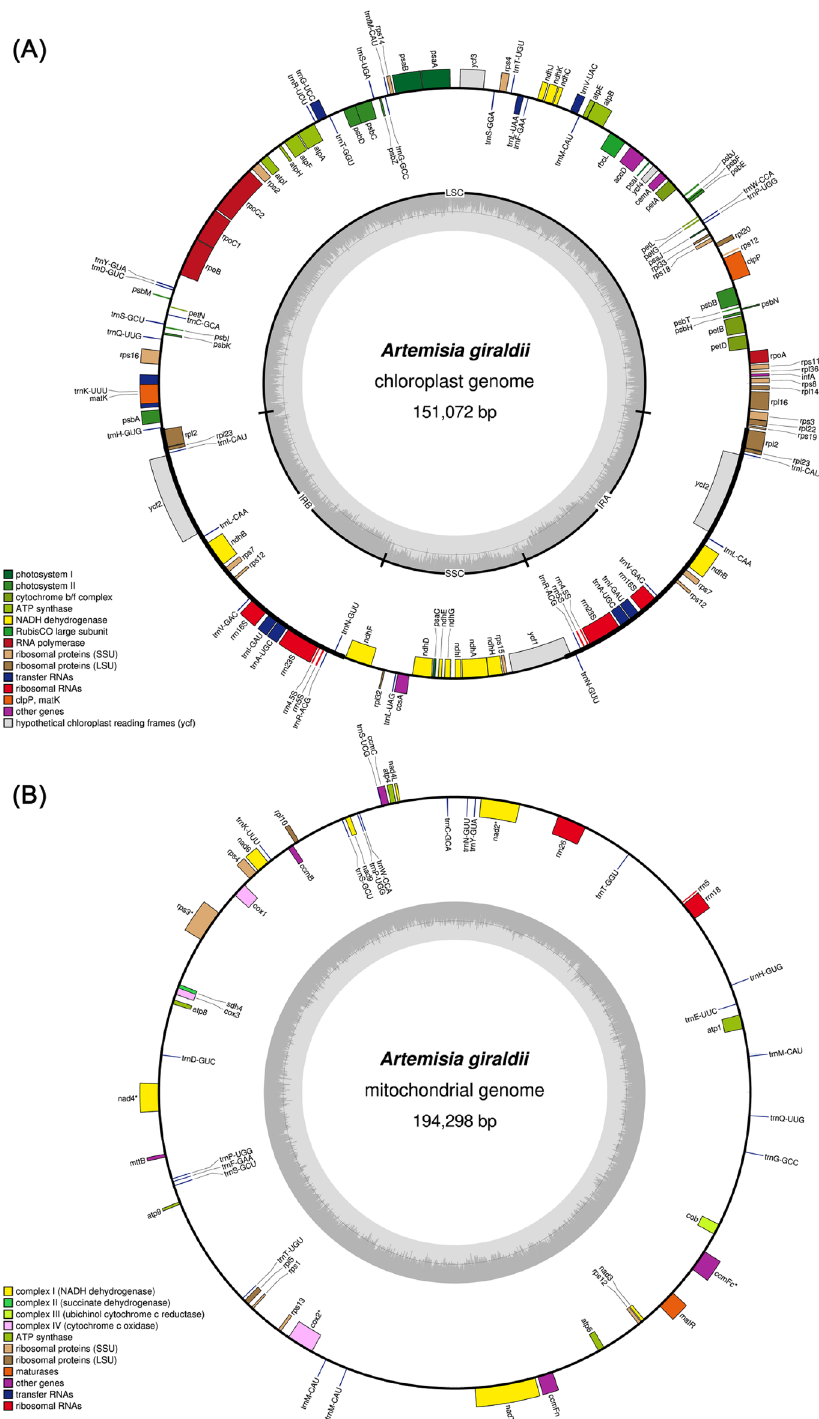
Figure 1. The circular maps of the organelle genomes of A. giraldii . ( A ) The circular map of the plastome. ( B ) The circular map of the mitogenome. The functions of the different colored genes on the map are shown on the left. The dark gray region in the inner circle indicates the GC content. The circular maps of two organelle genomes were drawn by Geseq (https:// chlor obox. mpimp- golm. mpg. de/ geseq.